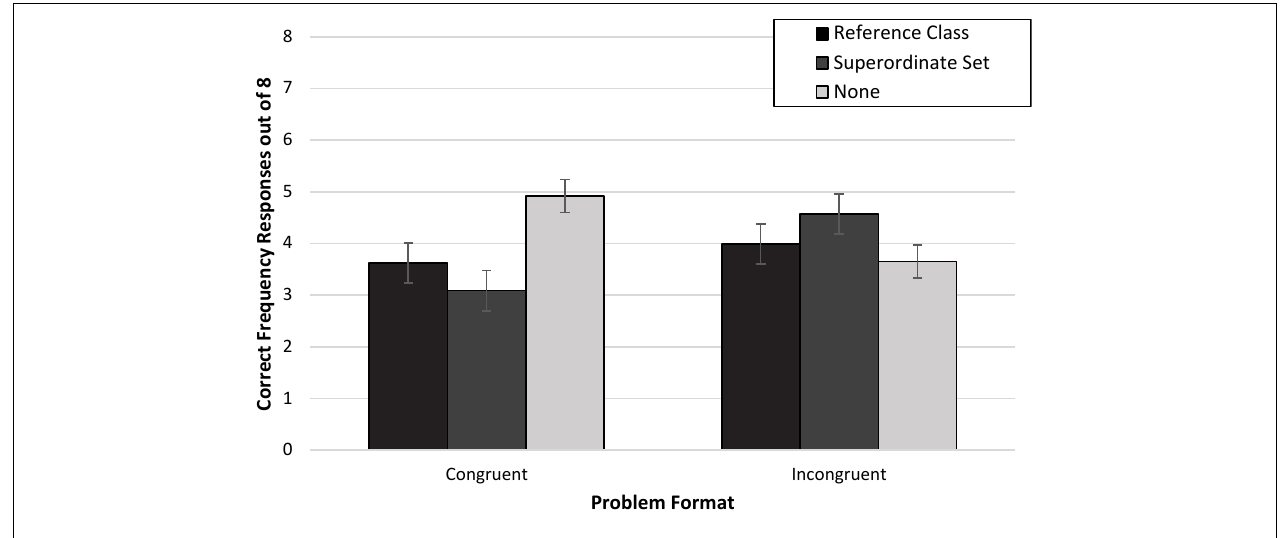
FIGURE 5 | Experiment 1c condition accuracy means while controlling for numeracy. Error bars indicate ± 1 SE.